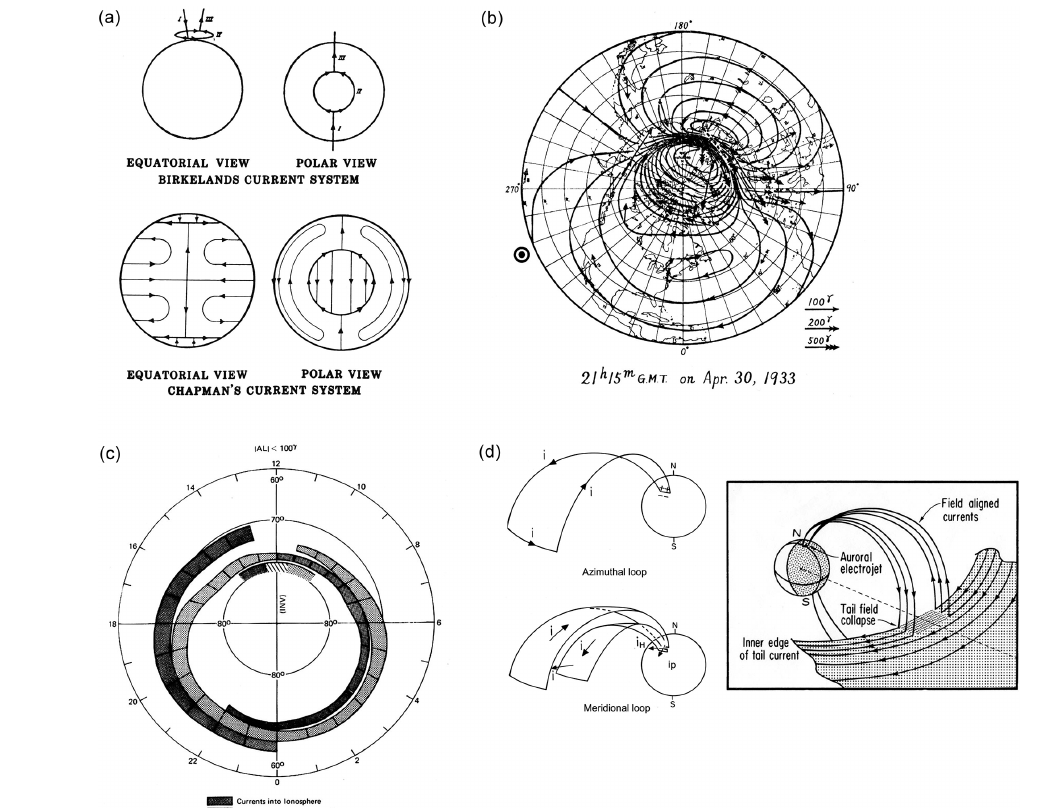
Figure 4. (a) Above: Birkeland’s three-dimensional current system. Below: Chapman’s two-dimensional current system. Both the equatorial and polar views are shown. (Chapman’s polar view is the same as that in Fig. 4e). (b) An example of the substorm current system on a spherical shell (Fukushima, 1953). (c) The distribution of the field-aligned currents (Iijima and Potmra, 1978). (d) Left: Bostrom’s current system. Right: the current system by Clauer et al.